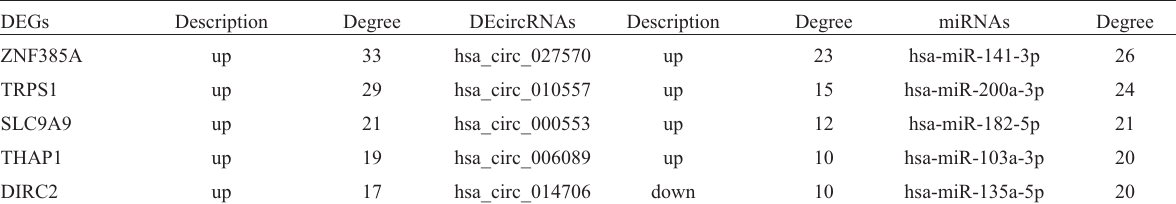
Figure 3 - The ceRNA regulatory network and functional enrichment analysis of DEmRNAs in ceRNA network. (A) The ceRNA network. Pink circles represent up-regulated genes, blue triangles represent miRNAs, light green rhombuses indicate up-regulated cicrRNAs, deep green rhombuses represent down-regulated cicrRNAs, blue solid lines depict the regulatory relations among different RNA transcripts, and dotted orange line indicates the co-expression relationships. (B) Functional enrichment analysis of DEmiRNAs in ceRNA network. The dot size shows the gene ratio and color ranging from blue to red indicates the increasing significance. - Table 3 - The top 5 DEGs, DEcircRNAs, and miRNAs in ceRNA